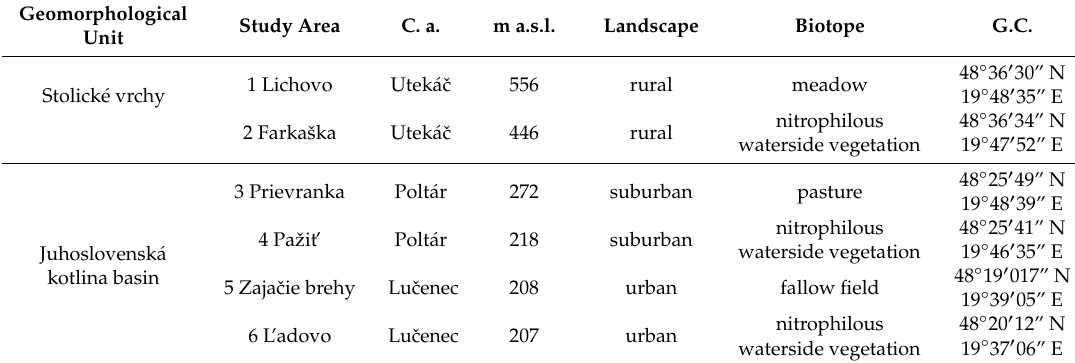
Table 1. Locality data of the study